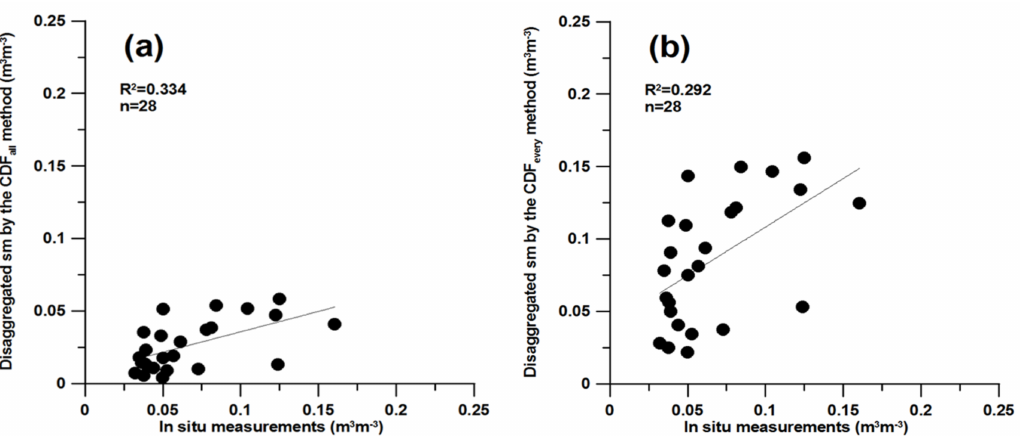
Figure 8. Evaluation of disaggregated soil moisture products by: ( a ) the CDF all ; and ( b ) the CDF every against the in situ